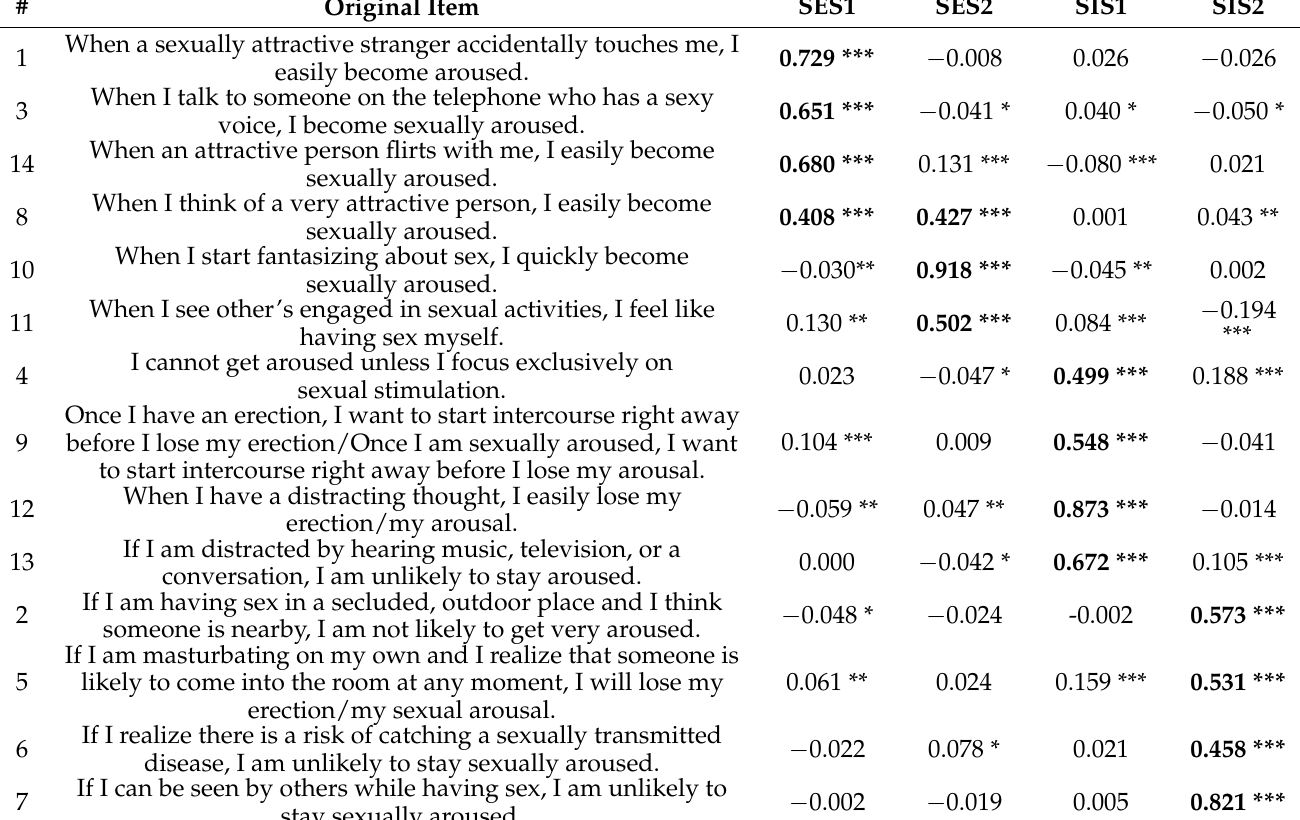
Table 3. Standardized loadings from an exploratory structural equation model with four factors.